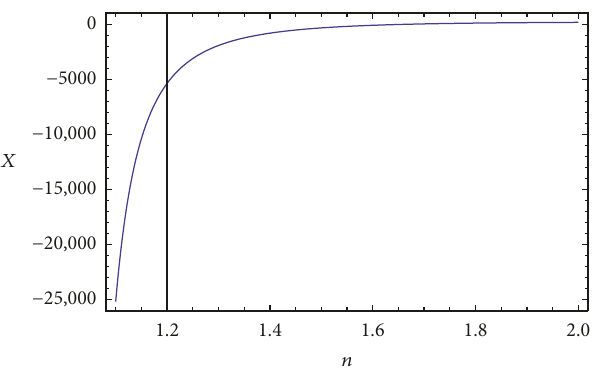
̈𝑆 tot by taking Bekenstein entropy as entropy